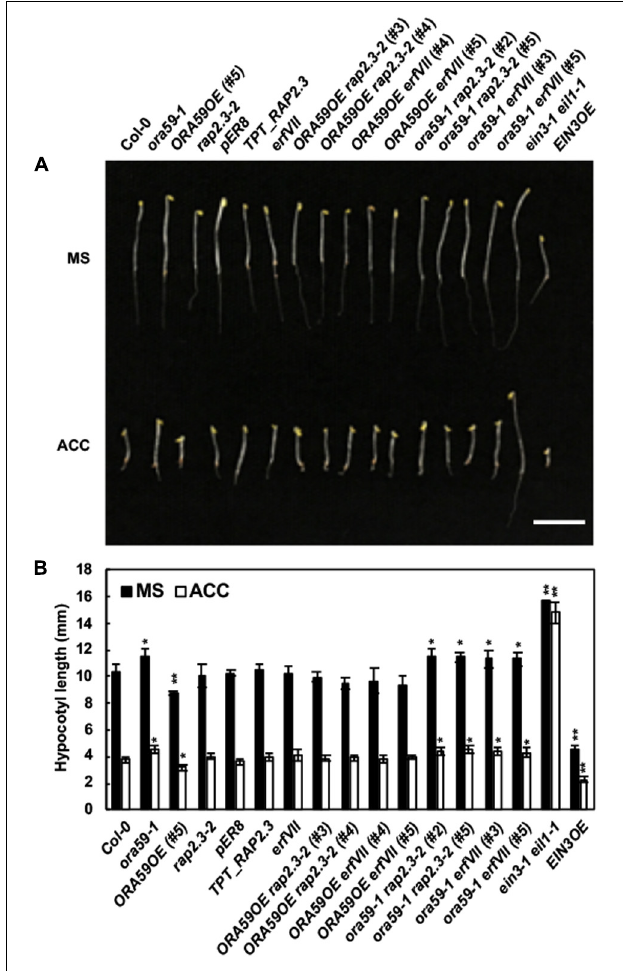
FIGURE 4 | Functions of ORA59 and RAP2.3 in the ethylene response. (A) Triple response phenotypes of 4-day-old etiolated seedlings of Col-0, ORA59 and RAP2.3 mutants and transgenics, erfVII , and their crossed lines in the presence or absence of 10 µ M ACC. Bar, 1 cm. (B) Hypocotyl lengths of seedlings in (A) . The values are means ± SD ( n = 15). Asterisks indicate significant differences from Col-0 ( t- test; ∗ P < 0.05; ∗∗ P <